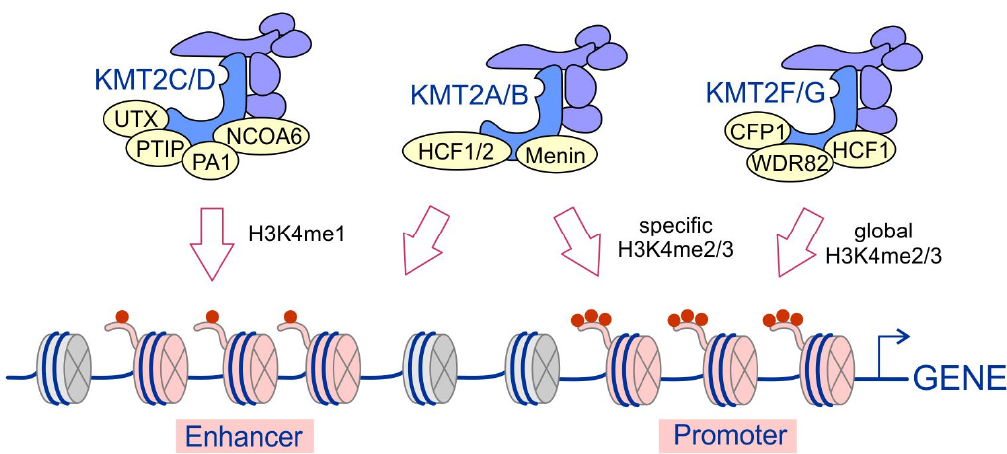
Figure 2. Specialization of COMPASS and COMPASS-like complexes in mammals. The KMT2F / KMT2G complexes, referred to as COMPASS complexes, are most similar to the yeast Set1 complex. These complexes are mainly responsible for bulk H3K4me3 genome-wide. The KMT2A / KMT2B and KMT2C / KMT2D complexes are referred to as COMPASS-like and are most similar to the Drosophila Trithorax complex and Drosophila Trithorax-related protein, respectively. KMT2A / KMT2B complexes are required for the H3K4 tri- and dimethylation in less than 5% of promoters and mainly regulate developmental genes. KMT2C / KMT2D complexes occupy enhancers and are responsible for H3K4 monomethylation.